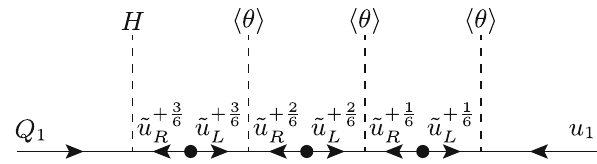
Fig. 6 Feynman diagram yielding an effective non-zero entry in ( Y ) u 11 . Each solid blob represents a mass insertion of 1